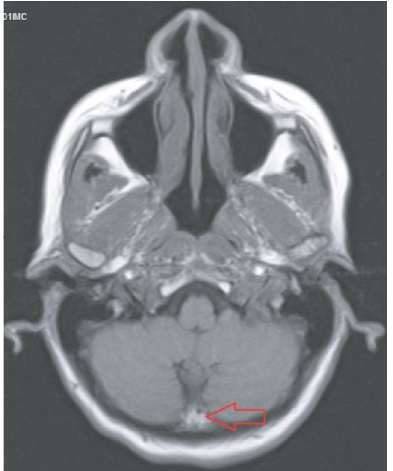
Figure 2: Patient MRI in axial view. Demonstrates calci fi cations in the supratentorial